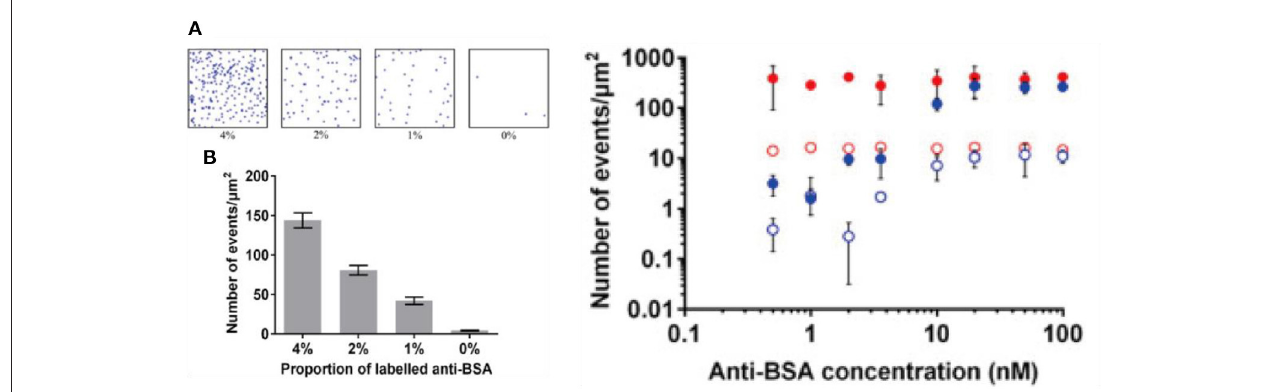
FIGURE 5 | Toward immuno-biosensors with SMLM. Shown above: (Left) (A) raw images of bovine serum albumin proteins immobilized on glass coverslips with self-assembled monolayer on transparent conducting oxide substrate. (B) A quantitative relationship is built with increased amount of labeled proteins on the surface (Right) adding an increasing amount of antibody results in an increasing number of counting per image area (Lu et al., 2017). Copyright with permission from Elsevier.